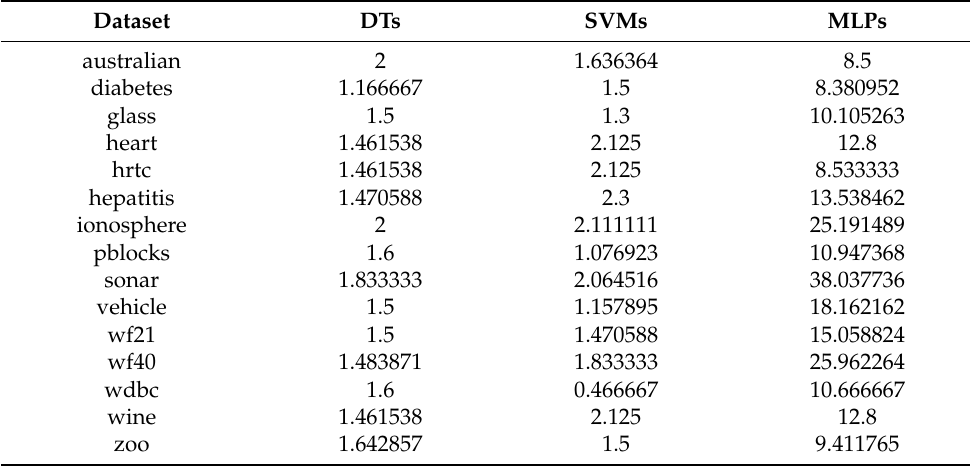
Table 8. Throughput gain of SRMLC compared to RMLC [33].